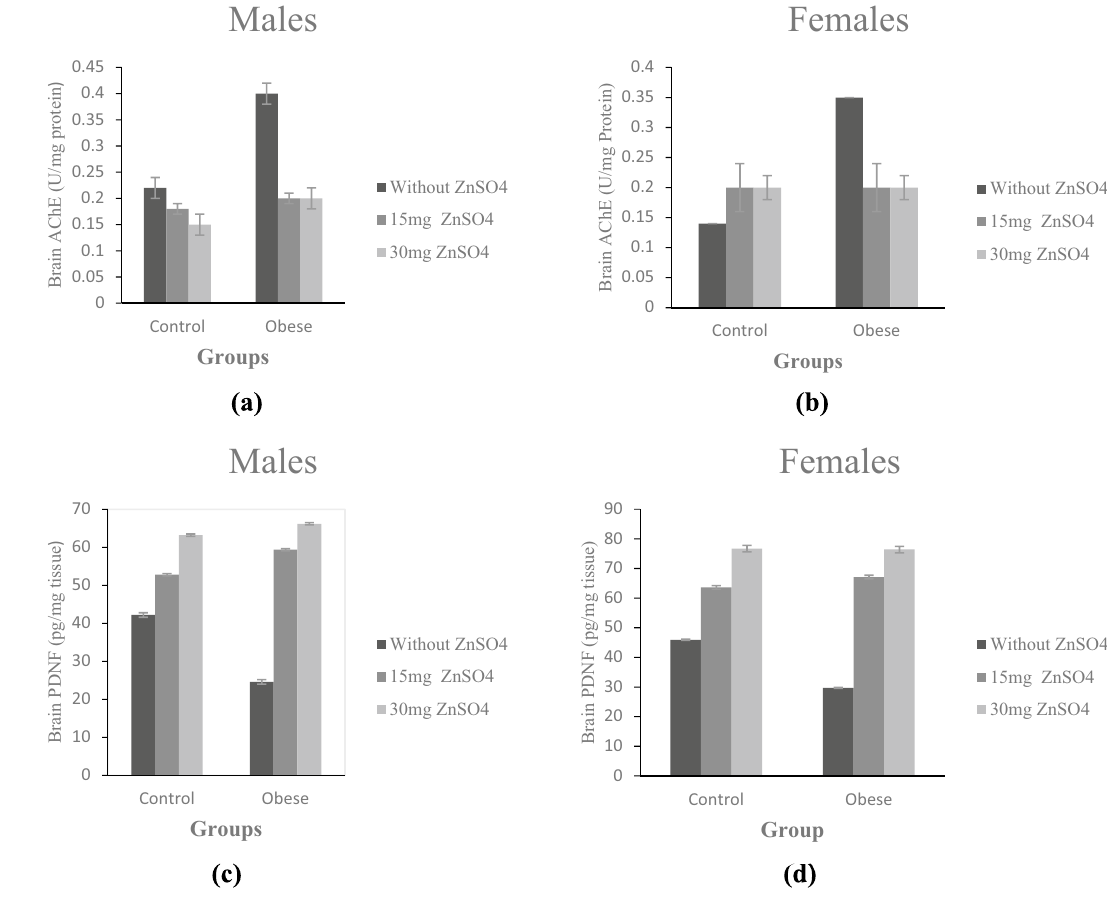
Figure 2. ( a , b ) Brain tissue levels of AChE (U/mg tissue) in control and obese groups; without ZnSO 4 , 15 mg ZnSO 4 , and 30 mg ZnSO 4 in male and female rats, respectively; ( c , d ) Brain levels of PDNF (pg/mg tissue) in control and obese groups; without ZnSO 4 , 15 mg ZnSO 4 , and 30 mg ZnSO 4 ; in male and female rats, respectively. Results are expressed as (mean ±